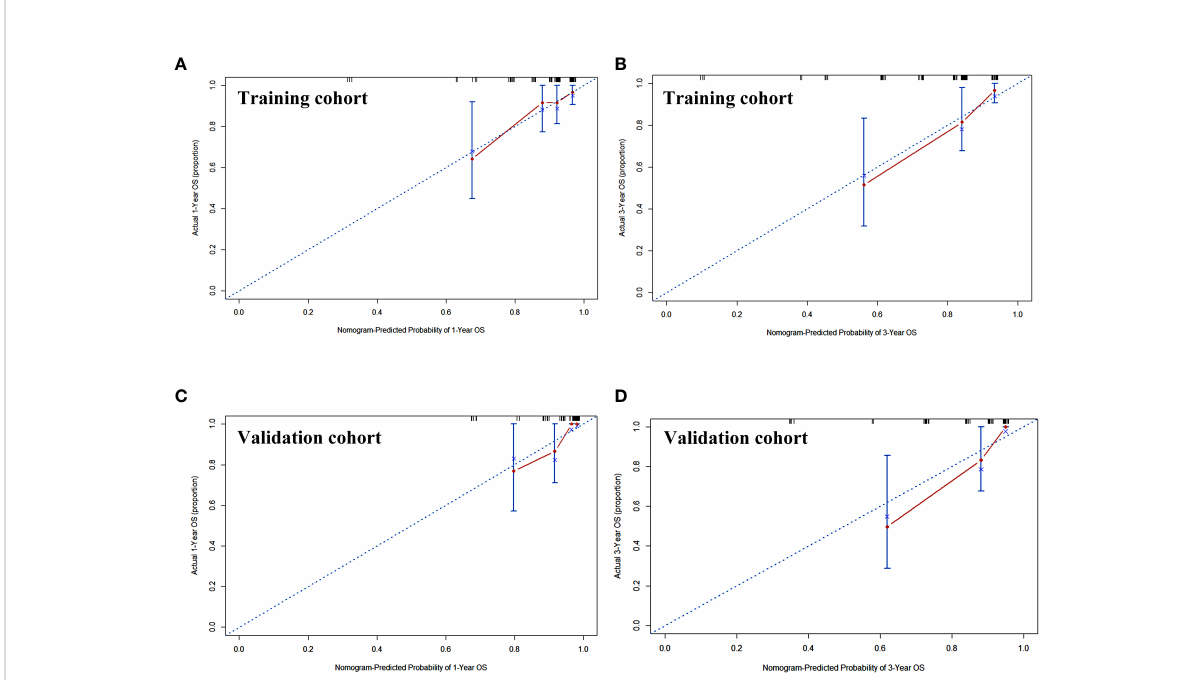
FIGURE 3 The calibration curve of the nomogram to predict the overall survival rate of 1 and 3 years in training cohort (A, B) and validation cohort (C, D) . x-Axis was the nomogram-predicted probability of 1 or 3 years of OS. y-Axis was the actual OS of the patients included in the study. OS, overall